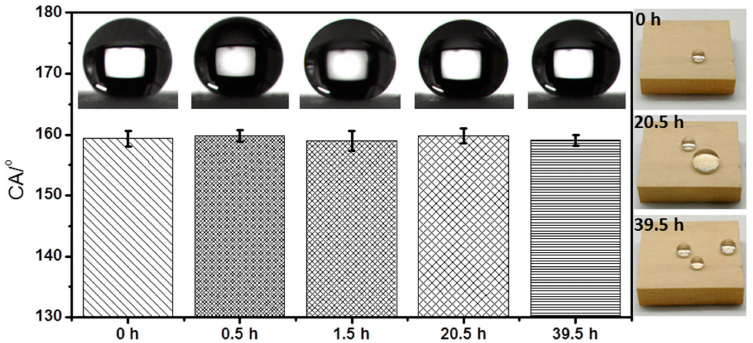
Figure 8. Water CAs and photographs of the coated sanded wood surface after being irradiated with 365 nm UV lamp (11.6 mW ∙ cm − 2 ) for different times.